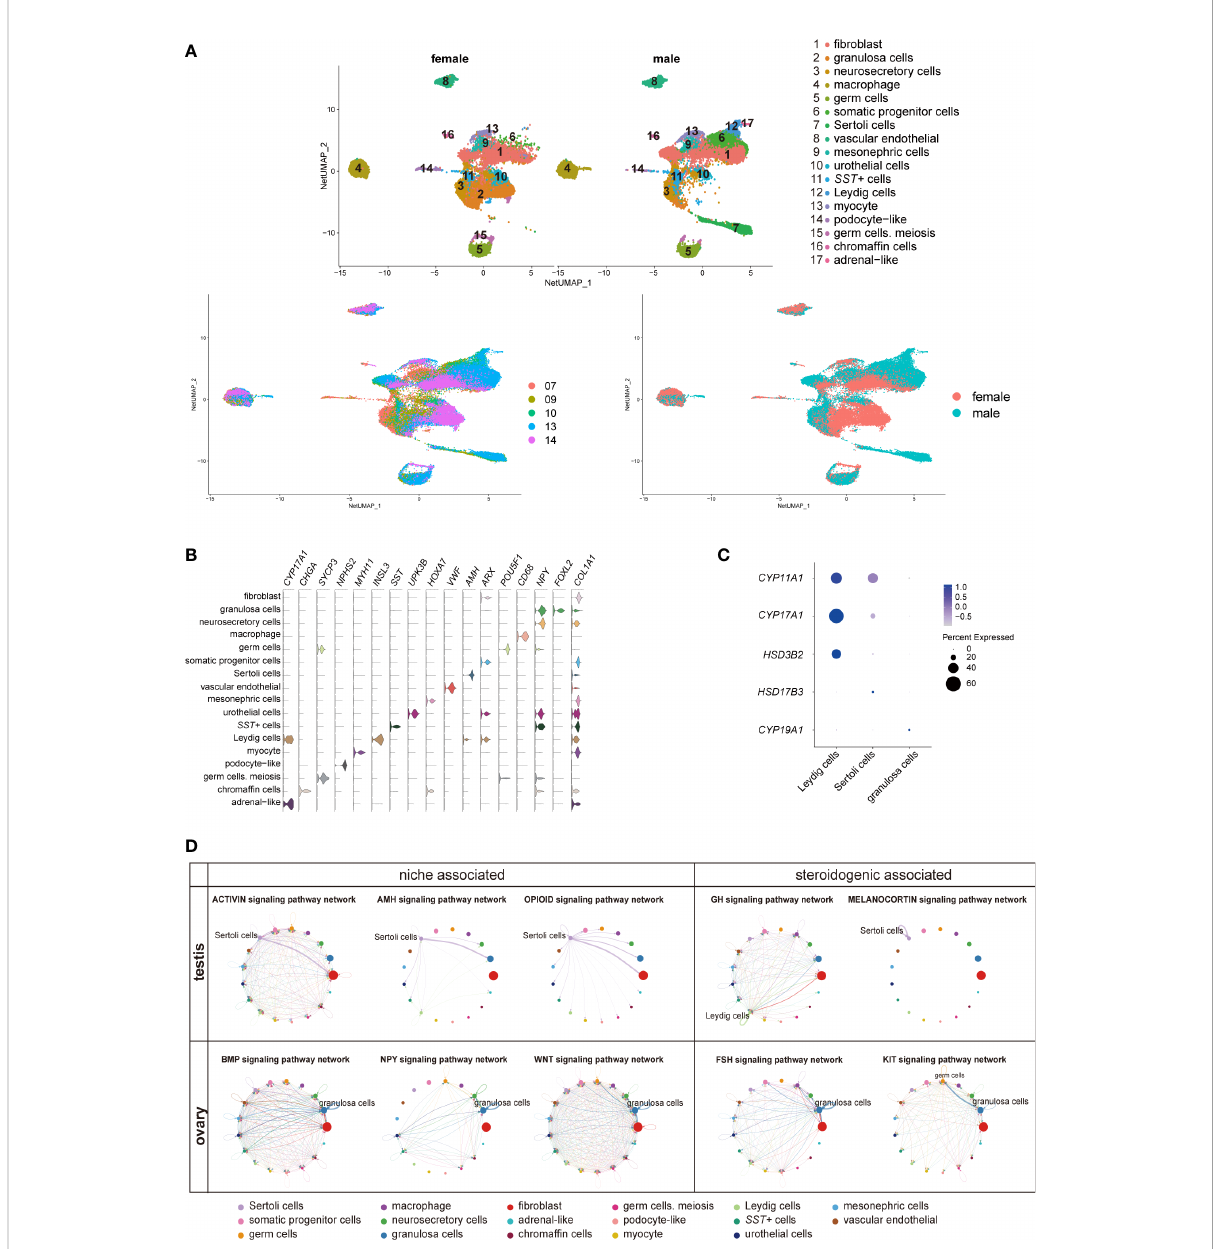
FIGURE 5 Transcriptomic landscape of human fetal gonads. (A) Uniform manifold approximation and projection analysis of the transcriptomes of all-stage fetal gonadal cells split by sex (n = 53,508). (B) Violin plot overview of the expression of selected marker genes by gonad clusters. Detailed cell information and differentially expressed genes can be found in Table S6. (C) Dot plot showing the expression of key enzymes for sex hormone biosynthesis ( CYP11A1 , CYP17A1 , HSD3B2 , HSD17B3 , and CYP19A1 ) in different gonadal somatic cells. (D) CellChat analysis showing the cell – cell interaction of gonadal somatic cells in the testis (top). The signal interaction pathway networks are divided into two functions: niche-associated (activin, AMH, and opioid) and steroidogenic-associated (GH and melanocortin). The cell – cell interaction of gonadal somatic cells in the ovary (below). The signal interaction pathway networks are divided into two functions: niche-associated (BMP, NPY, and WNT) and steroidogenic-associated (FSH and KIT).